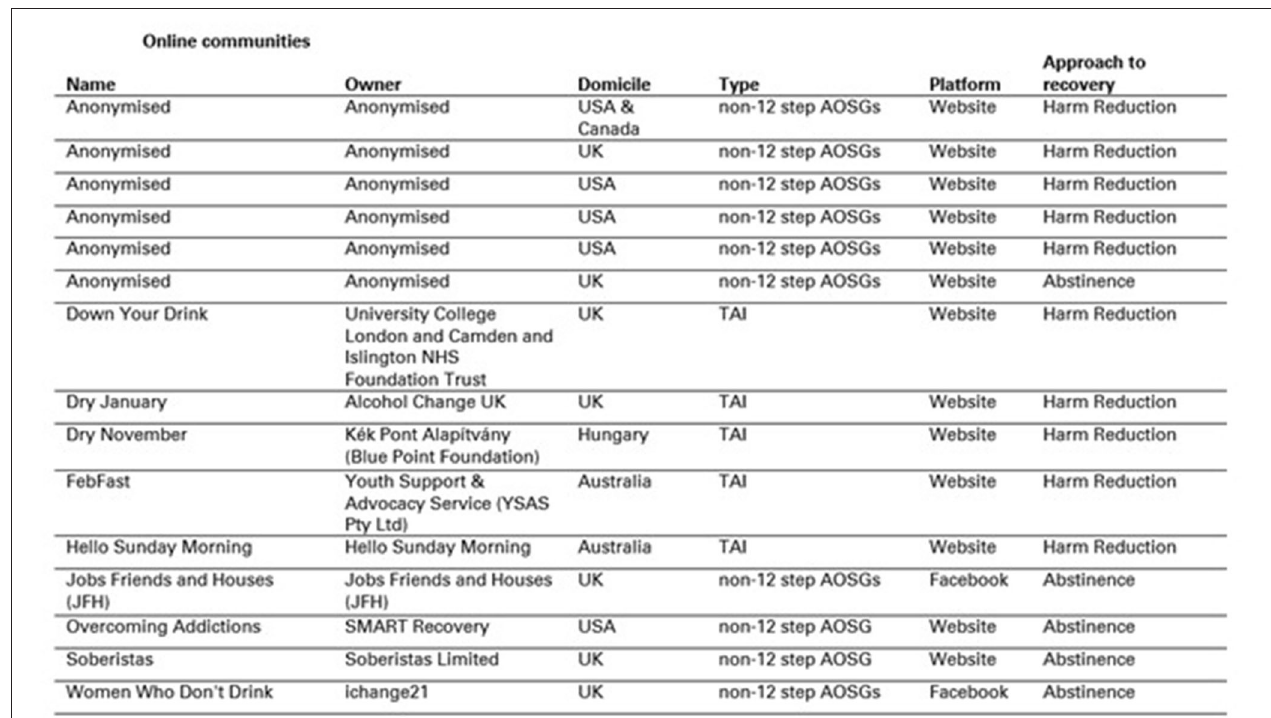
FIGURE 1 | Online